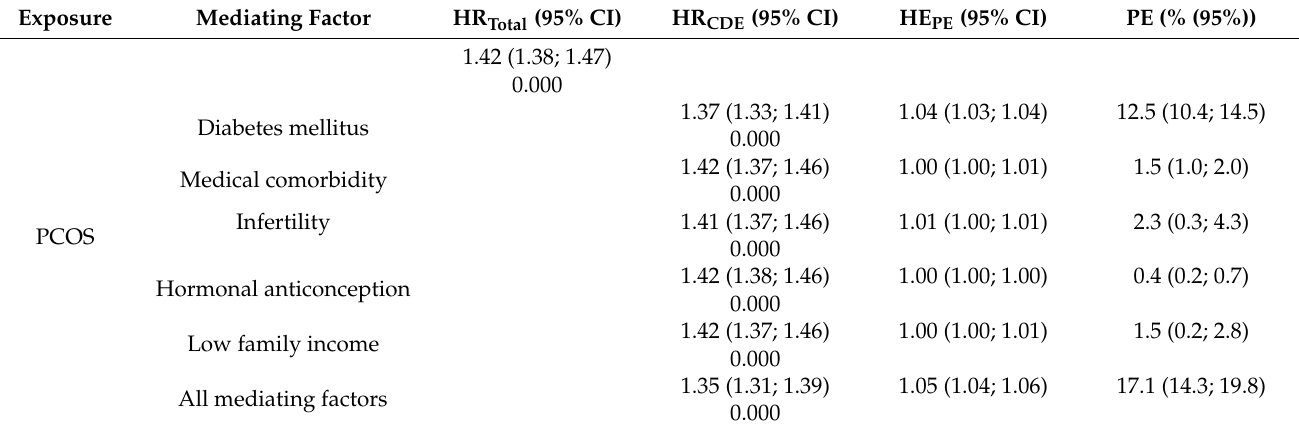
Table 3. Hazard ratios for development of depression in PCOS Denmark ( N = 18,476) and controls ( N = 54,757).